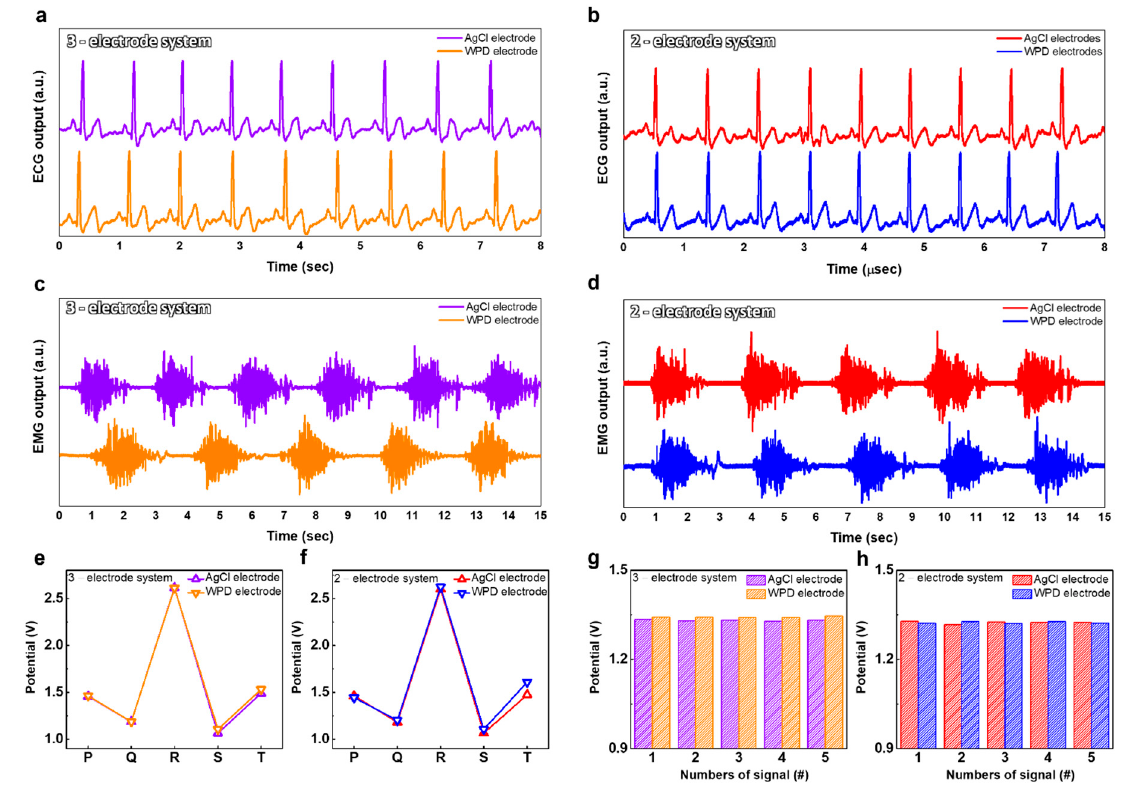
Figure 6. The biopotential signals of ECG and EMG with the WPD electrodes and commercial AgCl- based electrodes. ( a ) The ECG biopotential signals in 3-electrode system; ( b ) the ECG biopotential signals in 2-electrode system; ( c ) the EMG biopotential signals in 3-electrode system; ( d ) the EMG biopotential signals in 2-electrode system; ( e ) the PQRST peak in 3-electrode system; ( f ) the PQRST peak in 2-electrode system; ( g ) the quantified EMG biopotential signals in 3-electrode system; ( h ) The quantified EMG biopotential signals in 2-electrode system.